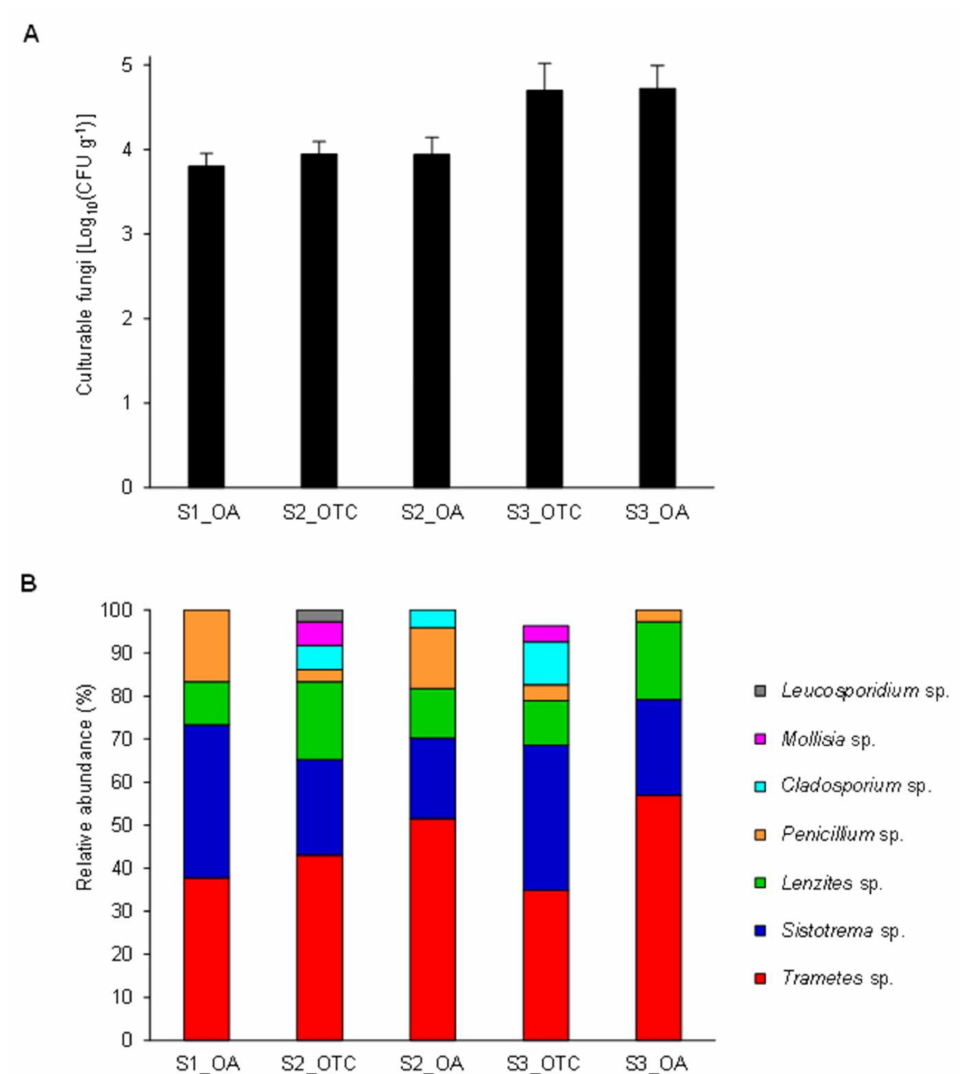
Figure 1. Endophytic fungi from Colobanthus quitensis leaves. ( A ) Colony-forming units (CFU) of culturable endophytic fungi per fresh plant weight unit (g) were evaluated for C. quitensis plantlets harvested in open areas (OA samples) as well as inside open-top chambers (OTC samples). Culturable fungi were grown at 25 ± 1 ◦ C for 21 days on potato dextrose agar (PDA) supplemented with 0.25% lactic acid. No additional colonies could be observed for a longer incubation time. Mean Log 10 (CFU g − 1 ) and standard deviation values from three replicates (each as a pool of plants) are presented for each sample. ( B ) Relative abundances of taxa of culturable endophytic fungi assessed by morphological analyses. No significant differences were found among the collection sites (OA and OTC), according to Tukey’s test ( p >